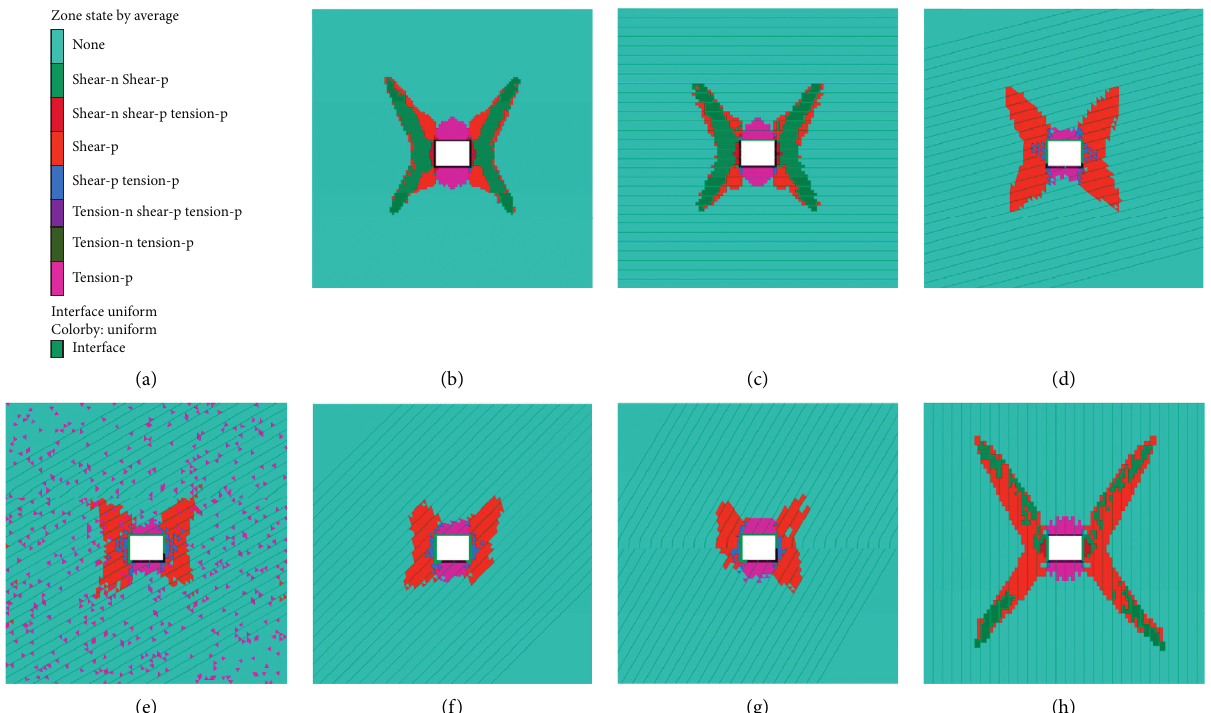
Figure 6: Plastic zone of seven models. (a) Plastic zone legend. (b) No structural plane. (c) Horizontal structural plane. (d) Structural plane with 15 ° . (e) Structural plane with 30 ° . (f) Structural plane with 45 ° . (g) Structural plane with 60 ° . (h) Vertical structural plane.